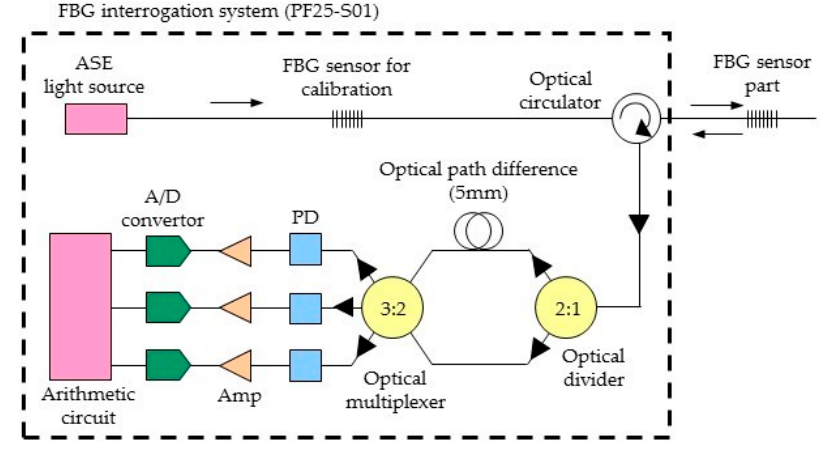
Figure 1. The block diagram of the interrogator and FBG sensor.